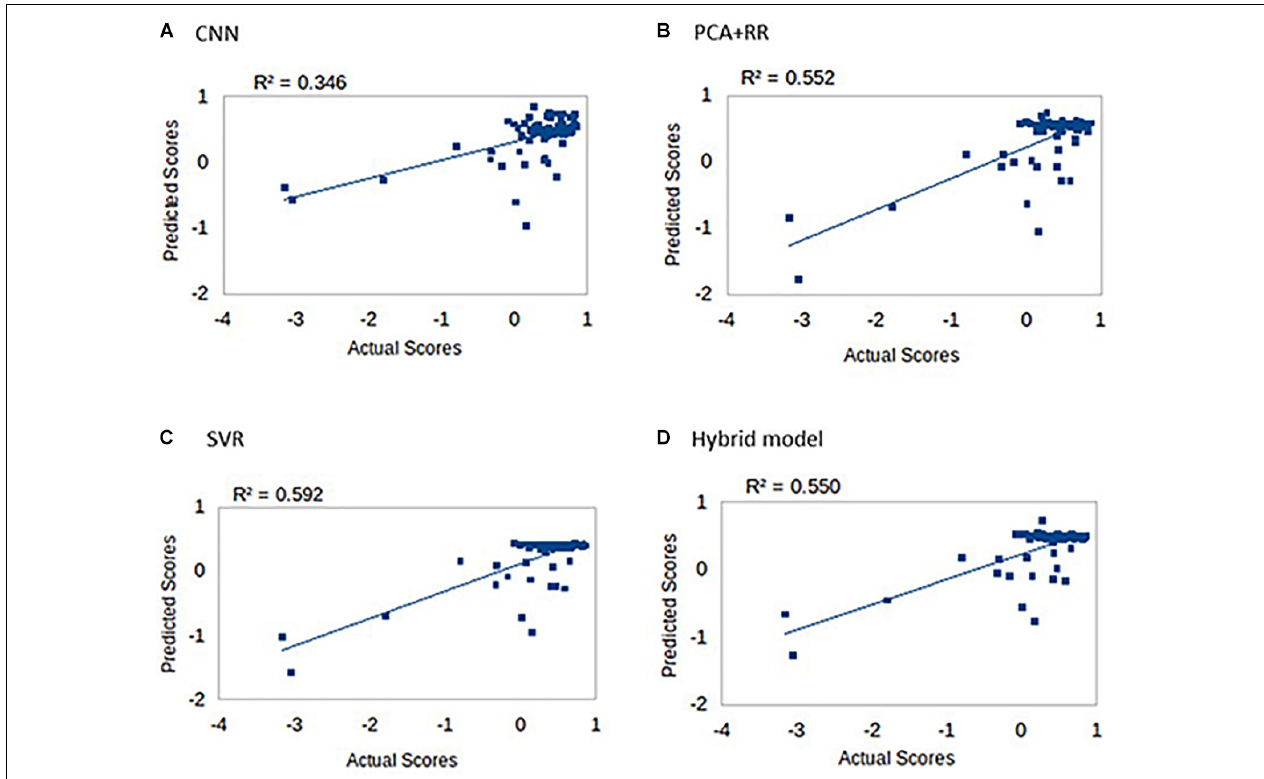
FIGURE 8 | Long-term language scores predicted by the four machine learning models: (A) CNN, (B) PCA + RR, (C) SVR, and (D) Hybrid model. Predictive accuracy is indexed by R 2 values.